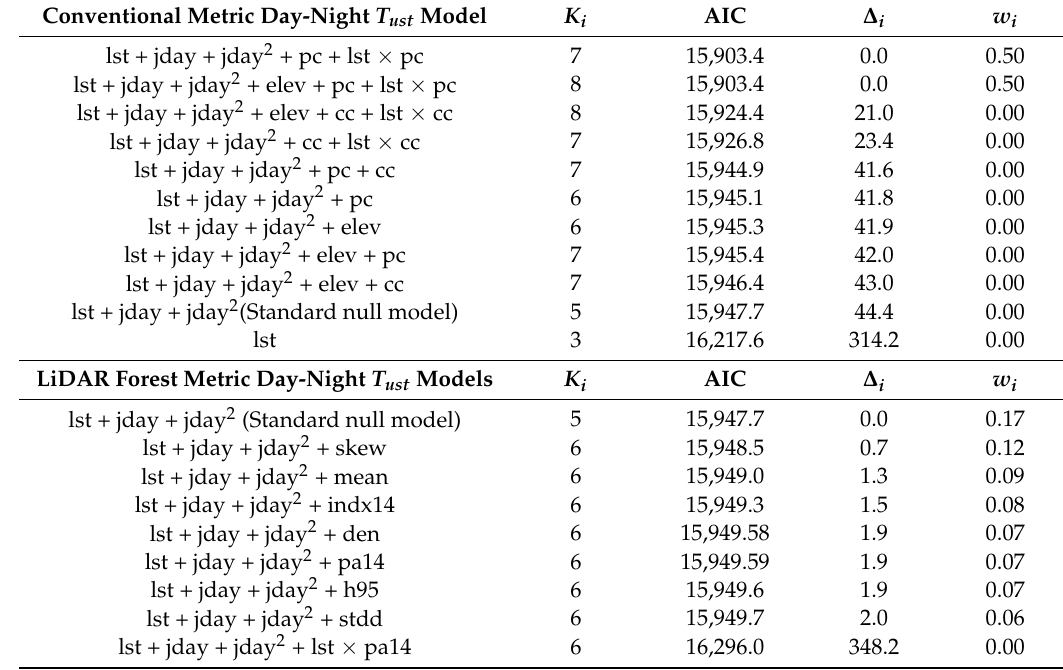
Table 3. Baseline Akaike information criterion (AIC) model rankings (top 10) showing relative performance of conventional and LiDAR-derived variable types, as well as individual variable contributions in estimating T ust using all clear-sky (day–night) observations. Model rank was assessed through difference in AIC values ( ∆ i ) and weights ( w i ) reflecting model likelihood. Model complexity is characterized by the number of model parameters ( K i